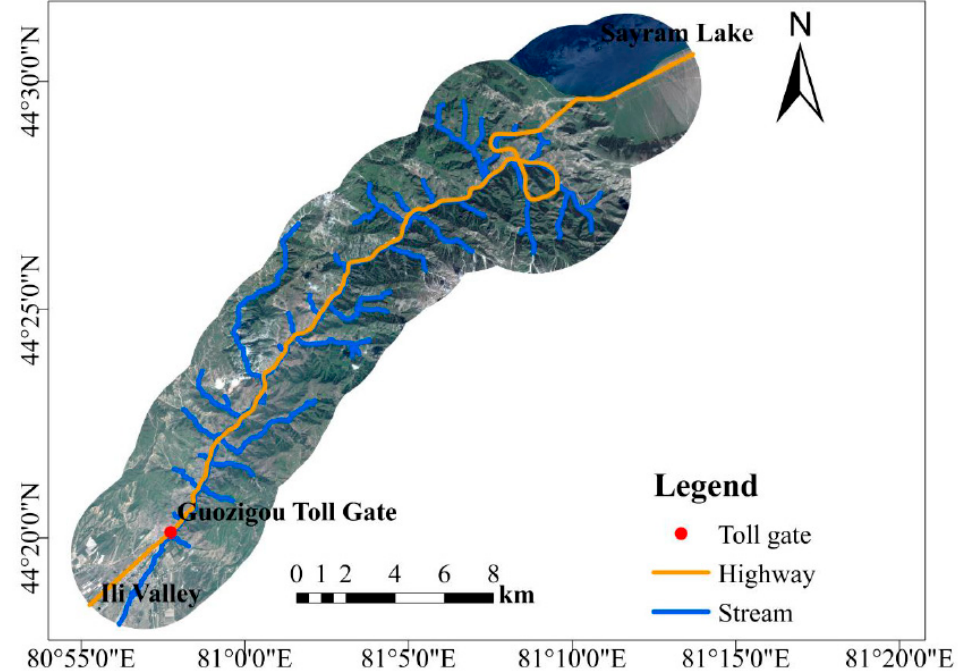
Figure 2. Location map of the study area where the background is the GF-1 satellite bands 1, 2, and 3 true-color composed image acquired in July 2020.